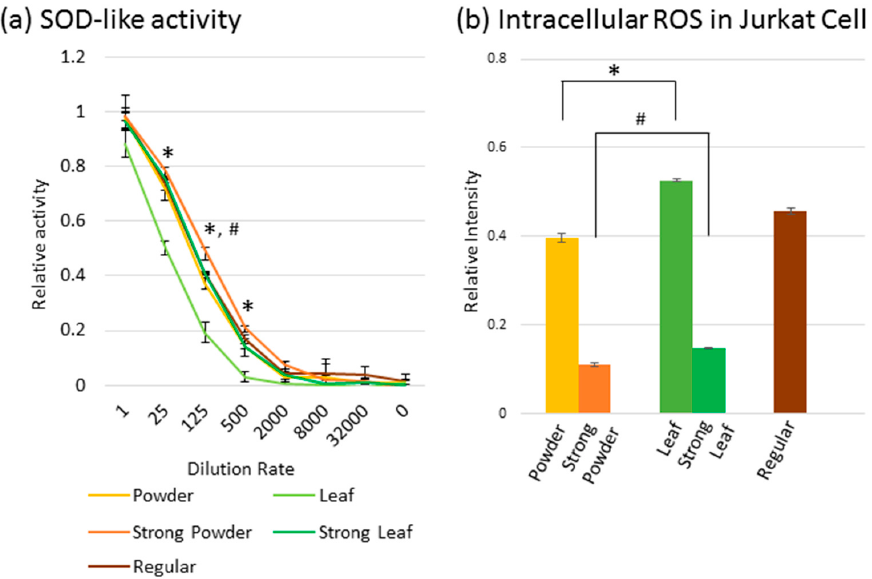
Figure 4. Differences in reactive oxygen species (ROS) inhibitory effects of green teas in vitro : ( a ) superoxide dismutase (SOD)-like activity of green teas at indicated dilution rate; and ( b ) intracellular ROS intensity in Jurkat cell line added with green teas (1/500 dilution). * and # indicate differences between Powder vs. Leaf tea and Strong Powder vs. Strong Leaf tea at 5% significant level, respectively (Bonferroni/Dunn method).